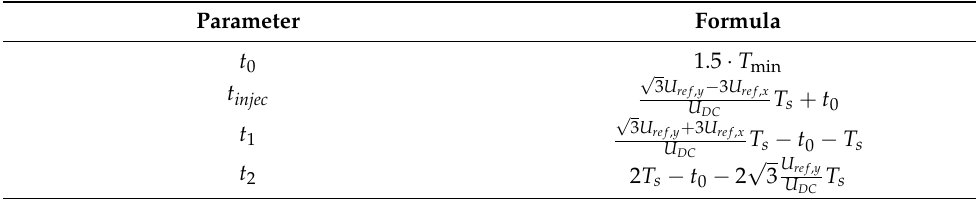
Table 10. Time calculation for the proposed SVM pattern for Region 4 applied inside the outer